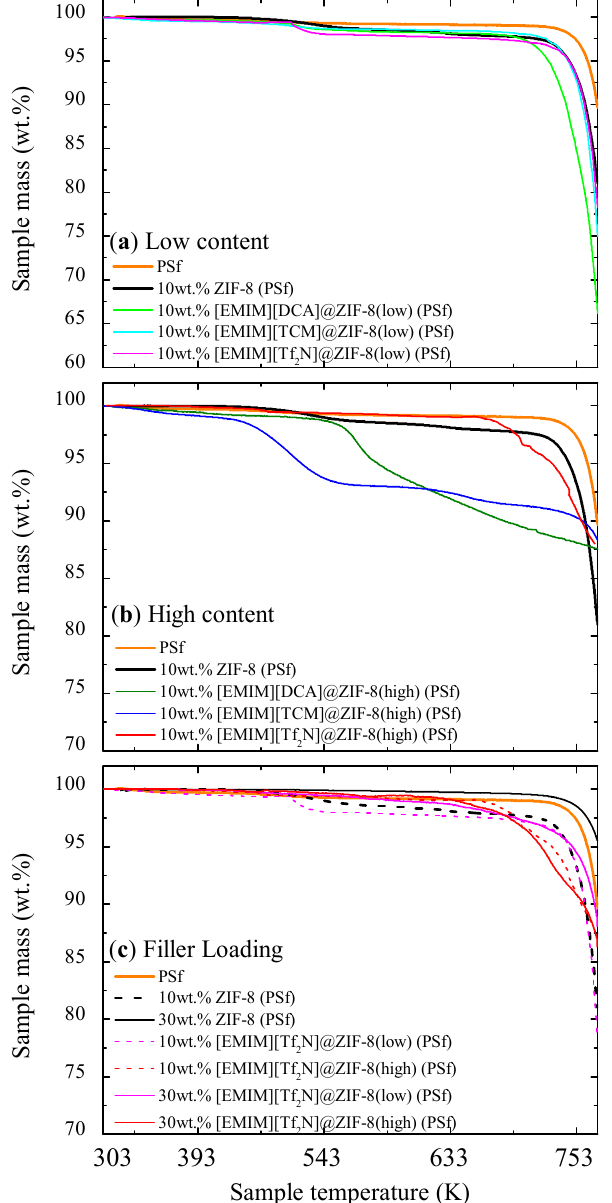
Figure 6. Thermal stability of PSf-based MMMs considering ( a ) 10wt.%IL@ZIF-8 composites low MMMs; ( b ) 10wt.%IL@ZIF-8 composites high MMMs; and ( c ) 10wt% and 30wt.%[EMIM][Tf 2 N]@ZIF- 8 composites (low and high) MMMs.